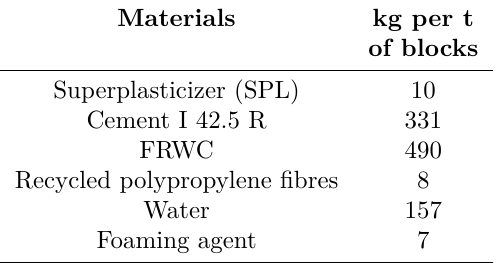
Table 1. Description of materials used for 1 t of